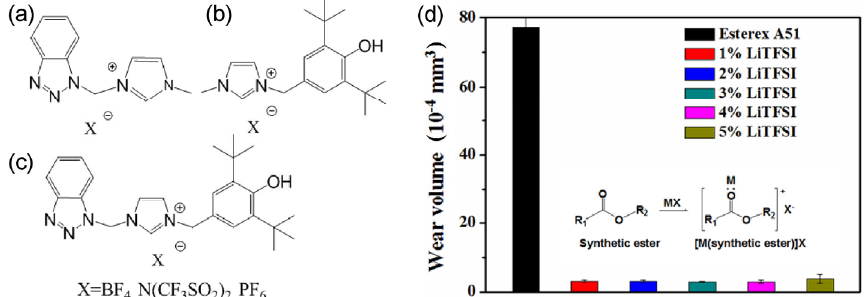
Fig. 16 Functionalized ionic liquids [79–81], and in-situ formed ionic liquids as the additive [86]. Reproduced with permission from Ref. [86]. Copyright American Chemical Society,